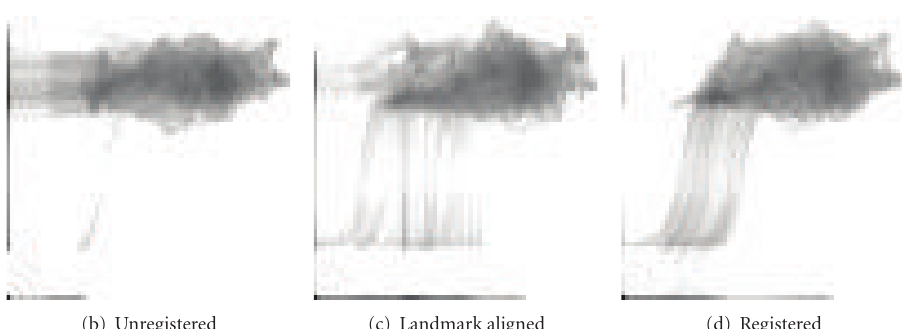
Figure 12: Registration results for sample MLO data set of Figures 4 and 5. The change in joint entropy plots can be observed as registration is